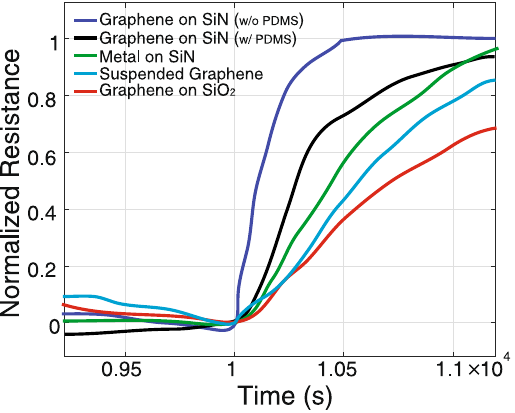
Figure 5. Transient response of the graphene temperature sensors with 5 °C temperature change is compared with thin film (40 nm Ni) RTD results in a temperature controlled test environment. The graph shows the substrate effect on response of SLG temperature sensor. The surface property effect on sensitivity combined with the thermal time constant effect on the dynamic behavior of the graphene temperature sensor is